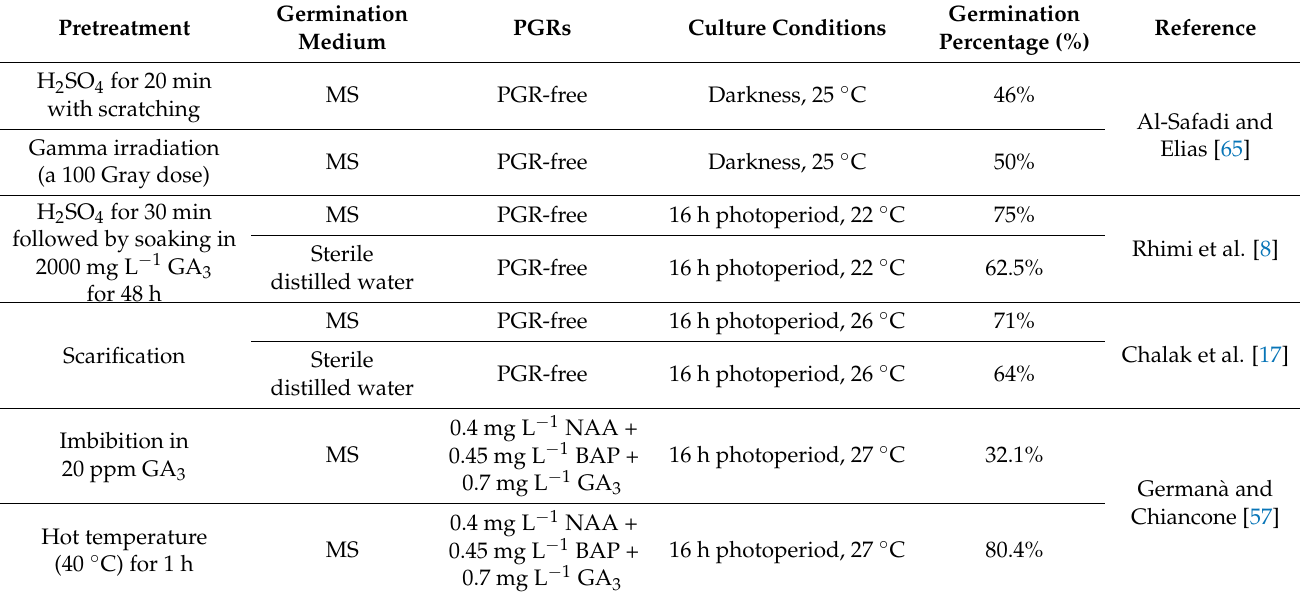
Table 1. In vitro seed germination of caper ( Capparis spinosa